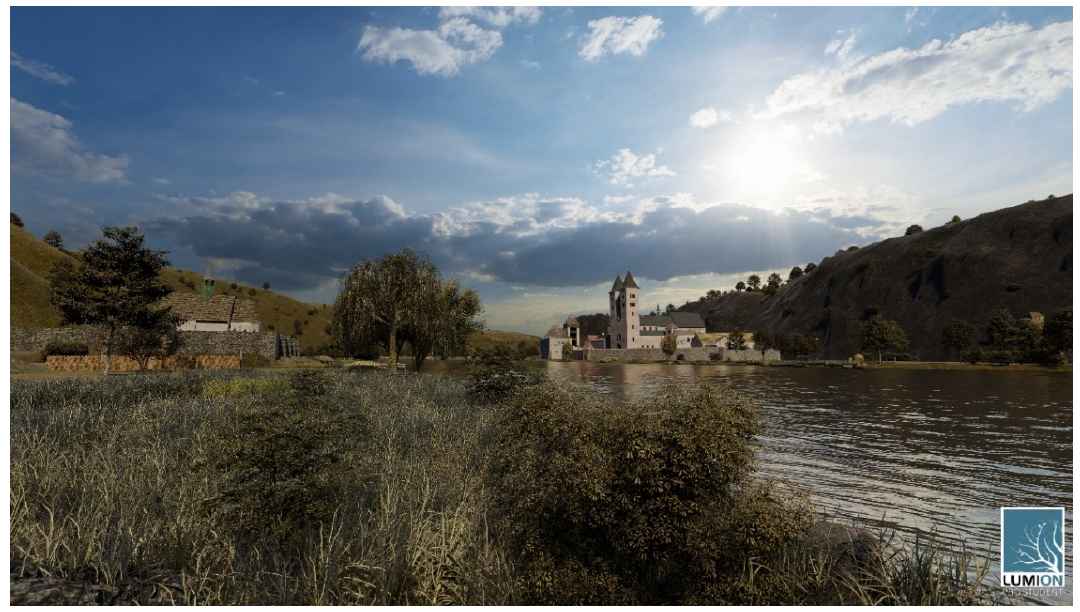
Figure A3. Visualization of Church of St. Kilián and the monastery in the Gothic era.